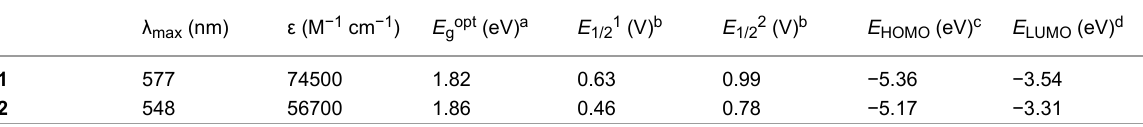
Table 1: Optical and electrochemical data, HOMO and LUMO energy levels of the dyes 1 and 2